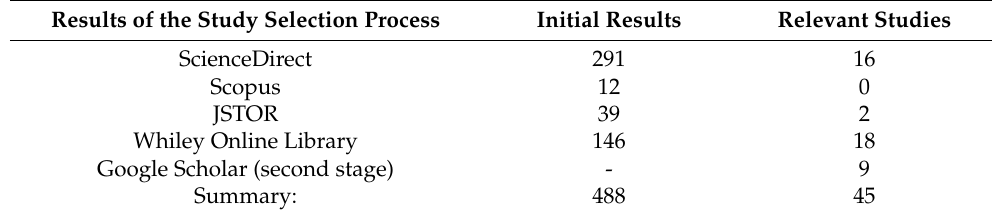
Table 3. Results of the paper selection